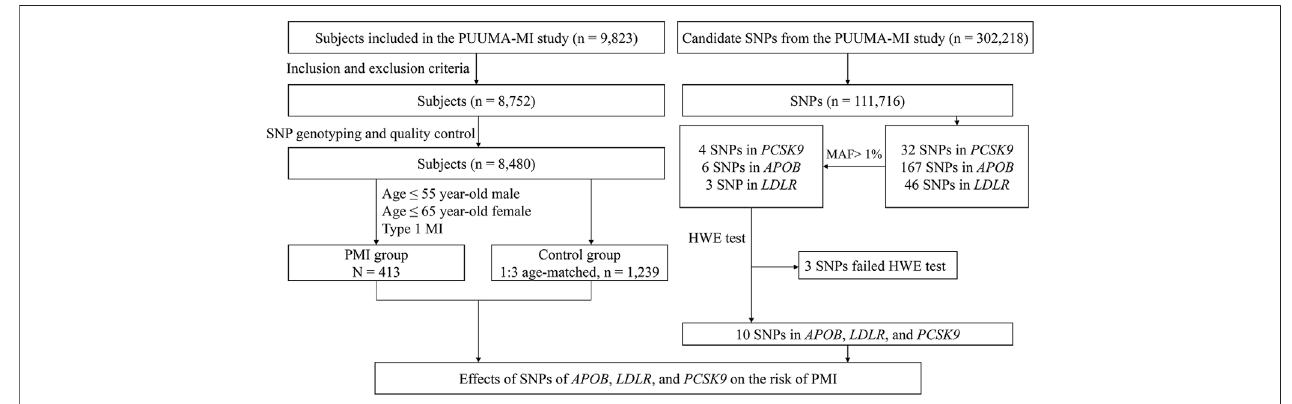
FIGURE 1 | Study fl ow diagram of Cohort 1. SNP, single-nucleotide polymorphism; PMI, premature myocardial infarction; MAF, minor allele frequency; PCSK9, proprotein convertase subtilisin/kexin type 9; APOB, apolipoprotein B; LDLR, low-density lipoprotein receptor; CHD, coronary heart disease.